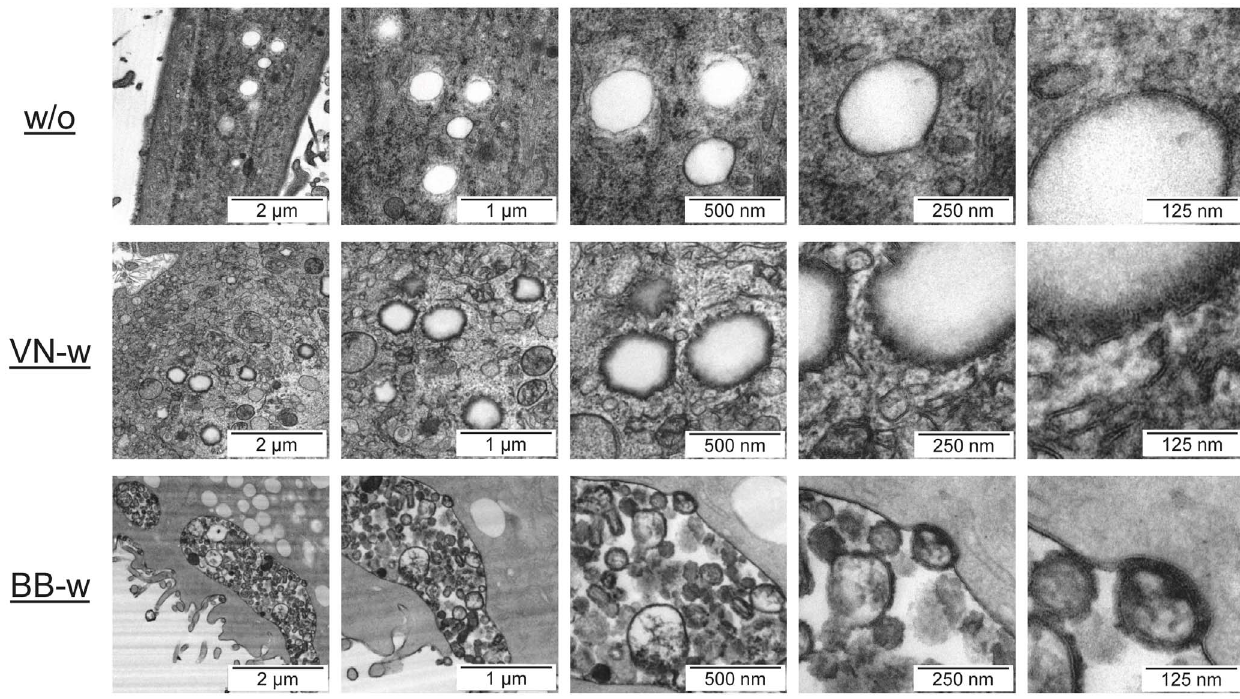
Figure 5. Endolysosomal escape of whole virus vaccine material. Immature DC were incubated for 2 h with TBS (w/o) or with whole virus vaccines of pandemic-like avian strain A/H5N1-Vietnam (VNw) or seasonal strain B/Brisbane (BBw). Subsequently, samples were processed and analyzed by TEM using a Zeiss 912 Omega microscope operated at 120 kV. Pictures were taken at 5 increasing magnifications to allow better detection and tracking of virus material.